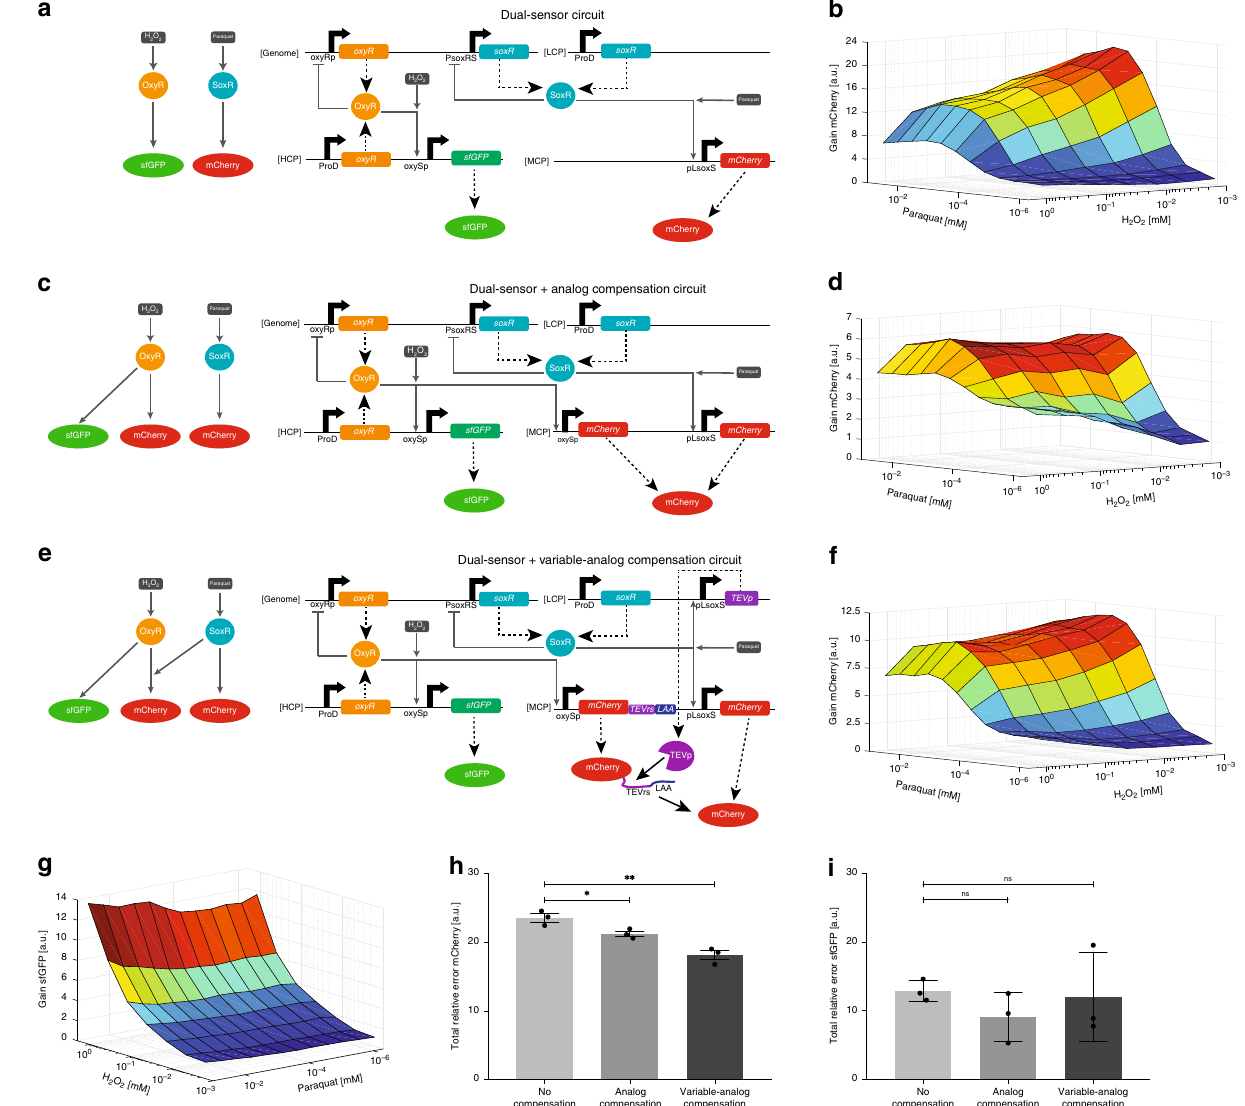
Fig. 3 Synthetic network-level crosstalk compensation. a The fi rst iteration of the dual-sensor circuit. SoxR is constitutively expressed from a LCP and activates mCherry expression from pLsoxS on a MCP. OxyR is constitutively expressed from a HCP and activates sfGFP expression from oxySp on the same HCP. Genomic soxR and oxyR expression are both negatively auto-regulated. Dashed large arrows represent protein production and solid small gray arrows represent transcriptional regulation. b The mCherry output fold-change relative to the minimum fl uorescence for the fi rst iteration dual-sensor strain at different concentrations of H 2 O 2 and paraquat. mCherry expression is mostly dependent upon paraquat concentration, but there is considerable crosstalk between H 2 O 2 and the mCherry output. c The dual-sensor circuit with analog compensation. We added an extra copy of mCherry controlled by oxySp to the dual-sensor circuit (Fig. 3a) so that the total mCherry level is controlled by both oxySp and pLsoxS promoter activity. d The mCherry output from the dual-sensor circuit with analog compensation. The crosstalk-compensation circuit reduced H 2 O 2 crosstalk at high paraquat levels, but increased crosstalk at low paraquat levels. e The dual-sensor circuit with variable-analog compensation. To the fi rst iteration of the dual-sensor circuit (Fig. 3a), we added an oxySp promoter on a MCP to express mCherry fused to TEVrs and an LAA degradation tag, as well as the TEVp gene on a LCP controlled by pLsoxS. TEVp post-translationally cleaves the LAA degradation sequence from the oxySp-expressed mCherry protein at the TEVrs site, stabilizing the mCherry protein. Solid black arrows represent post-translational events. f The mCherry output from the dual-sensor circuit with variable-analog compensation. H 2 O 2 crosstalk was substantially reduced at high paraquat concentrations compared to the original dual-sensor circuit without considerably increasing crosstalk at low paraquat concentrations. g The sfGFP output fold-change relative to the minimum fl uorescence for the fi rst iteration of the dual-sensor strain (Fig. 3a). sfGFP expression is dependent upon H 2 O 2 concentration and there is little crosstalk with paraquat. h , i The total relative mCherry ( h ) and sfGFP ( i ) error. The analog and variable-analog compensation circuits both reduce mCherry crosstalk signi fi cantly according to an unpaired two-sided t -test, without affecting the sfGFP error. The mean is shown for the total relative error calculated for each experimental replicate individually (represented by the dots). The data in Figs. 3b, d, f and g and the errors (s.e.m.) in Figs. 3h and i are derived from three biological replicates and fl ow cytometry experiments, each involving 30,000 events. * p < 0.05, ** p < 0.005, ns indicates p > .05. In Figs. 3b, d, f, and g, the lowest concentrations of paraquat and H 2 O 2 tested were zero, but are plotted as non-zero numbers so as to be shown on the logarithmic axes. Source data are provided as a Source Data fi le